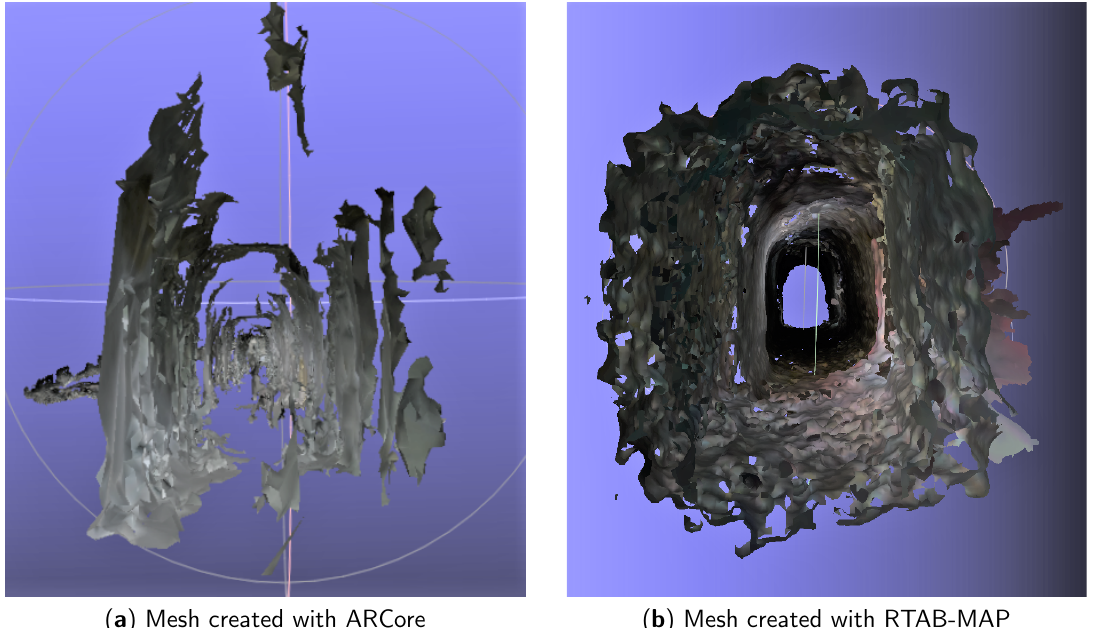
Figure 9. Meshes of the